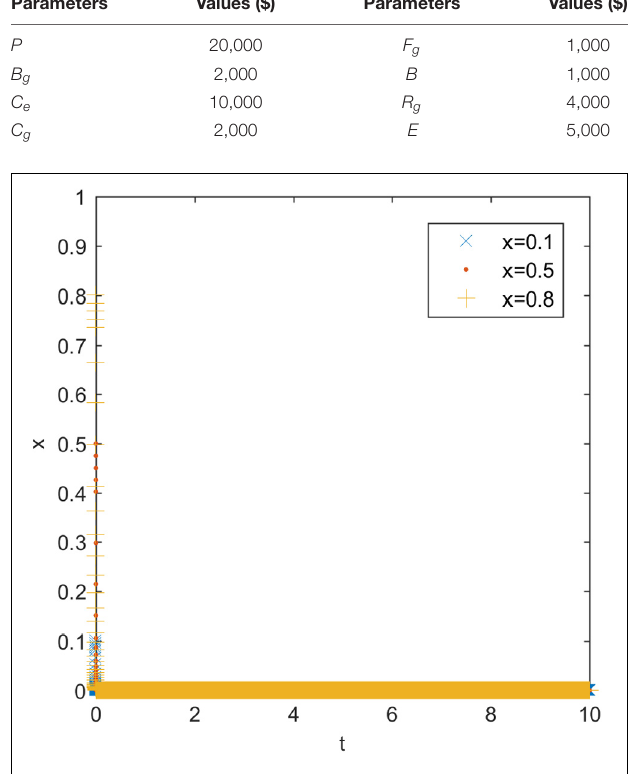
FIGURE 1 | G e − E ≥ P traditional energy enterprises’ evolutionarily stable